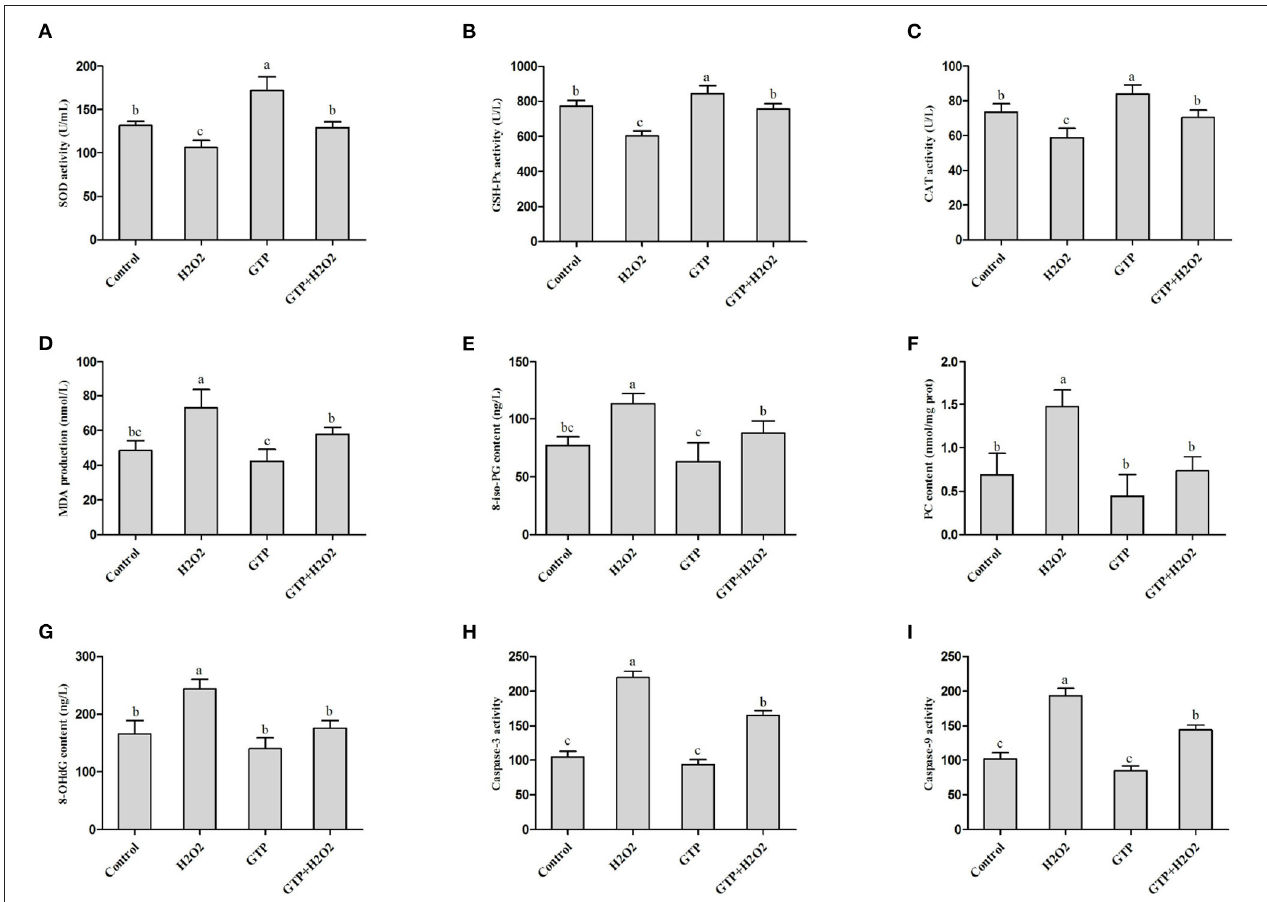
FIGURE 3 | GTP attenuated H 2 O 2 -induced oxidative stress. (A) SOD activity, (B) GSH-Px activity, (C) CAT activity, (D) MDA content, (E) 8-iso-PG content, (F) PC content, (G) 8-OHdG contents, (H) caspase-3 activity, and (I) caspase-9 activity. a,b,c, the adjacent lowercase letters indicate significant difference, the alternate lowercase letters indicate extremely significant difference, and the same lowercase letters indicate insignificant